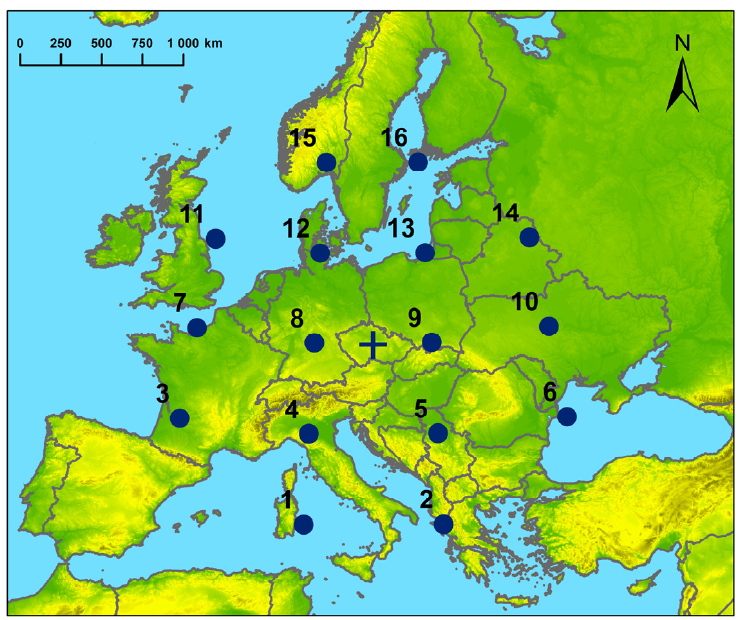
Figure 2. Position of the 16 SLP points as inputs for the calculation of circulation indices (the geographic center of the Czech Republic is indicated by a cross).